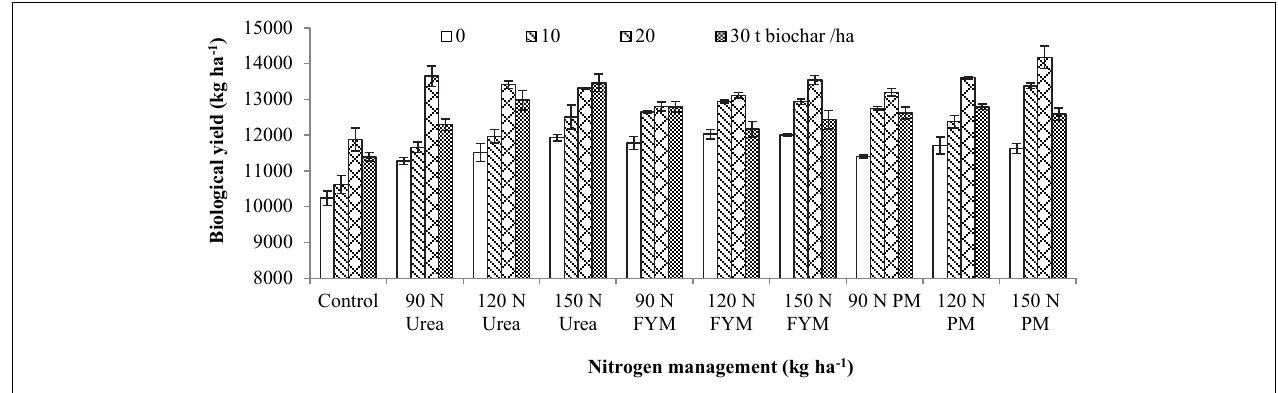
FIGURE 3 | Integrated impact of biochar and N levels applied from different sources on biological yield of wheat. Bars on the graph denote SE of mean ( n = 3). FYM, farmyard manure; PM, poultry manure.